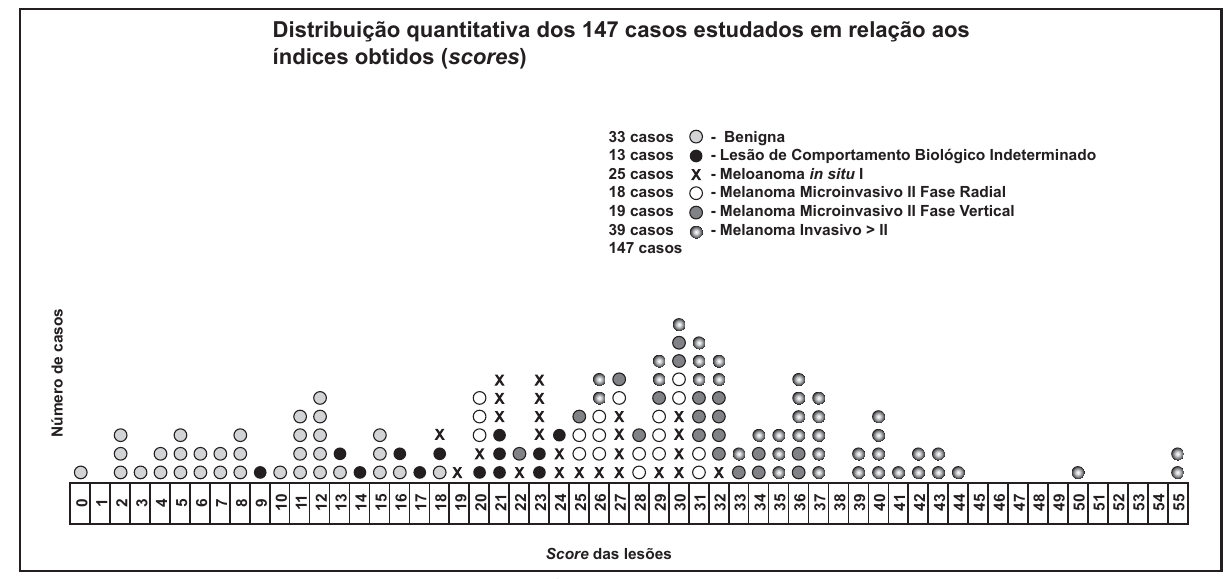
Figura 1 – Distribuição quantitativa dos 147 casos estudados em relação aos índices obtidos ( score